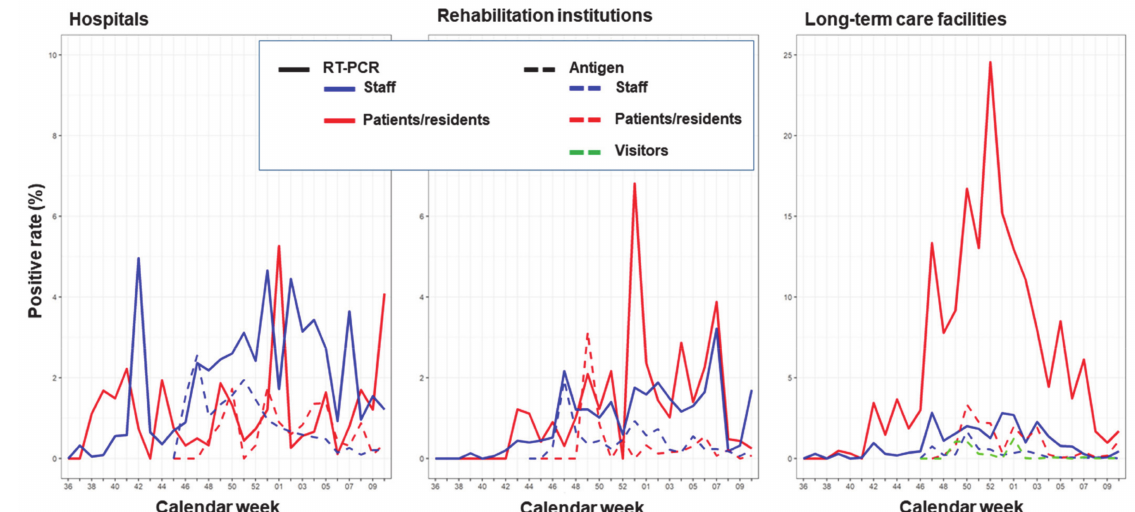
Figure 4. From September 2020 to March 2021, the weekly percentage of positive SARS-CoV-2 RT-PCR tests (solid lines) and positive SARS-CoV-2 antigen tests (broken lines) taken in asymptomatic staff, patients/residents, and visitors are presented, stratified by three types of healthcare institutions in the state of Bavaria, Germany. For visitors, only the antigen positivity tests in care facilities are shown due to an insufficient number of tests available for visitors of rehabilitation institutions and hospitals.